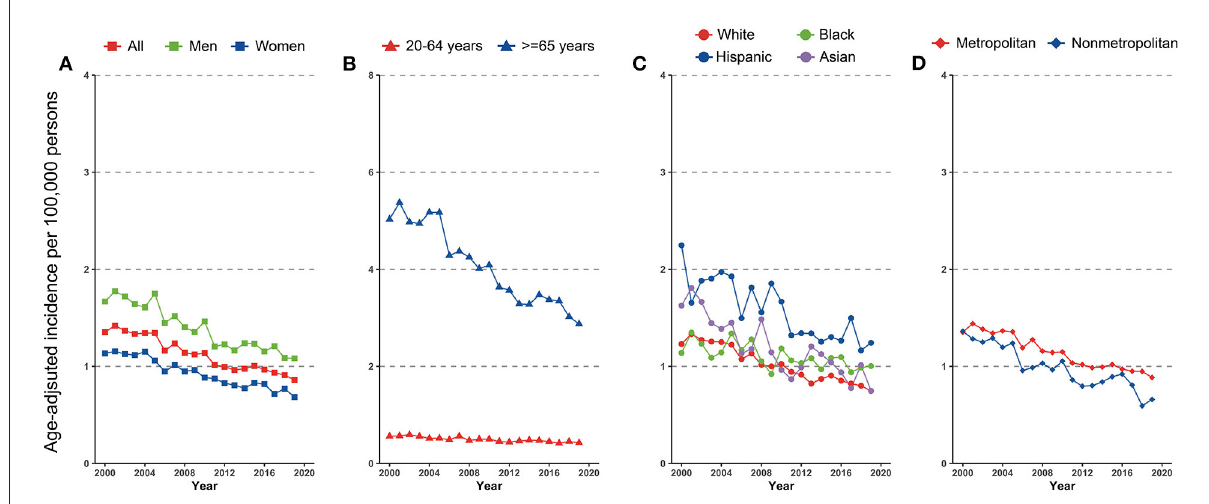
FIGURE2 Incidence trend in gastric non-Hodgkin lymphoma by (A) sex, (B) age, (C) race/ethnicity, and (D) geographic location among US adults, 2000–2019.